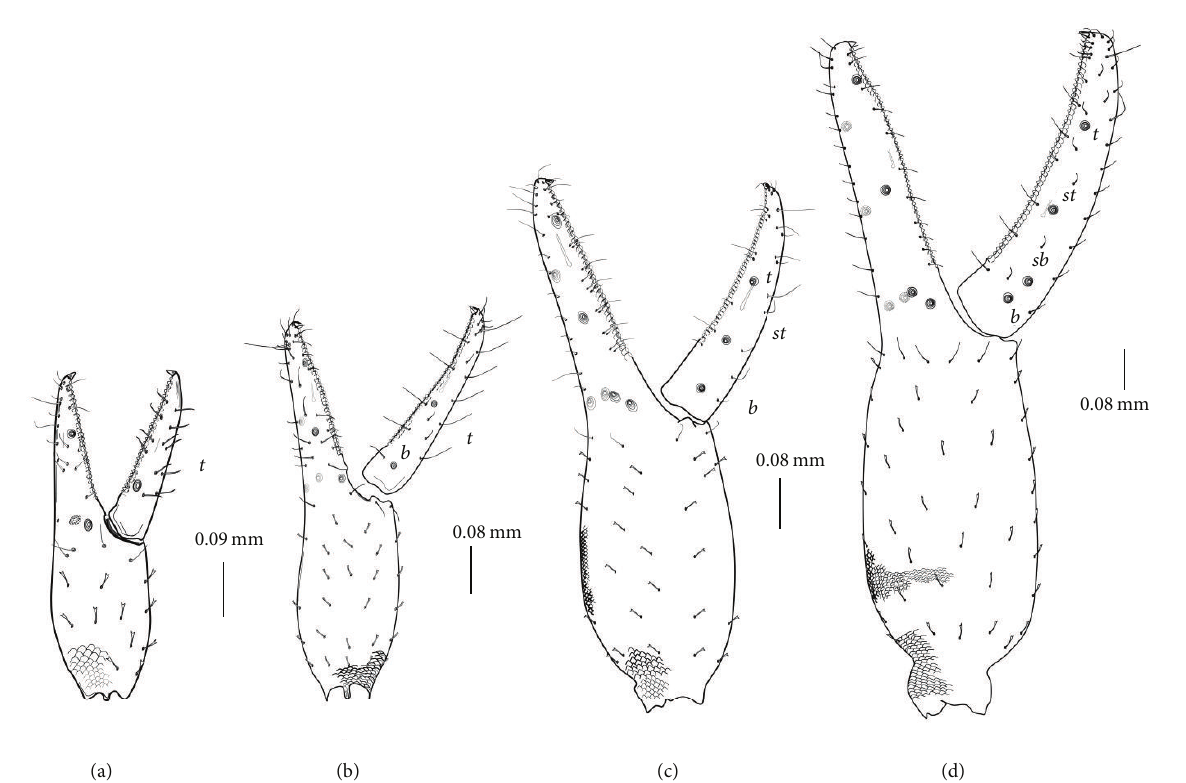
Figure 10: Right chela of Dactylochelifer gracilis : (a) protonymph, (b) deutonymph, (c) tritonymph, and (d) female.